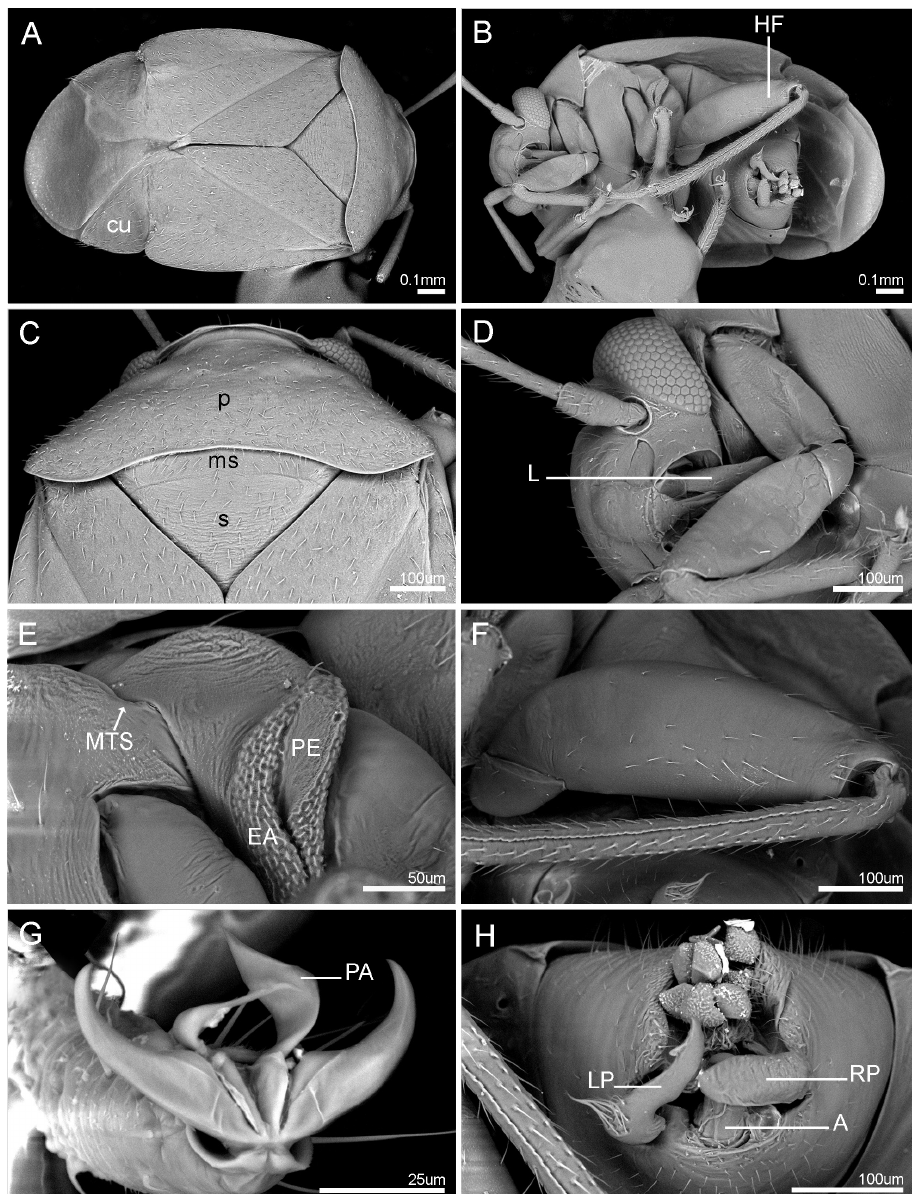
Figure 2. Scanning electron micrographs of key characters of Henryhalticus philippinensis gen. et sp. n. A Dorsal view of body B Ventral view of body C Pronotum and scutellum D Lateroventral view of head and thorax E Pterothoracic pleura, incl. external efferent system of metathoracic glands F Metafemur and metatibia G Pretarsus, dorsal view H Genital opening of pygophore. Abbreviations: A = aedeagus; cu = cu- neus; EA = evaporative area; HF = hind femur; L = labium; LP = left paramere; ms = mesoscutum; MTS = metathoracic spiracle; PA = parempodia; PE = peritreme; p = pronotum; RP = right paramere; s =